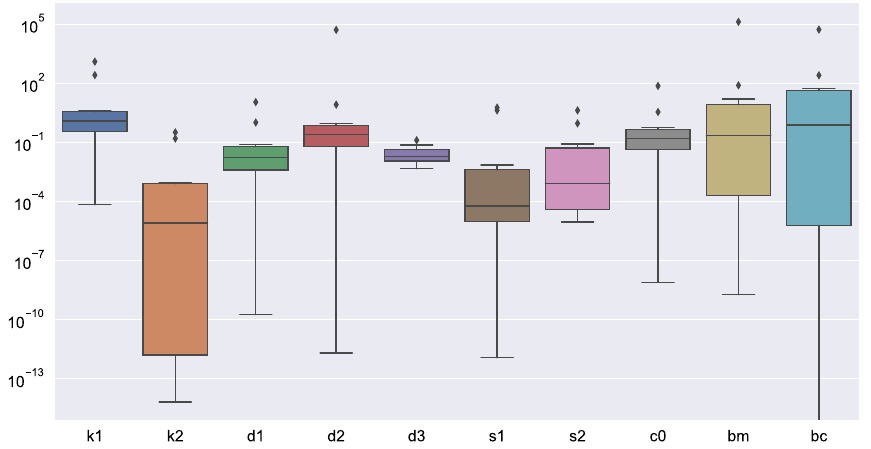
Figure 4. Box plot of the model parameters estimated from the best fit of the ODE system, Eqs. (4)–(6), to the RNA-Seq data. Each box shows the “dispersion” of eleven values, one per TA pair.